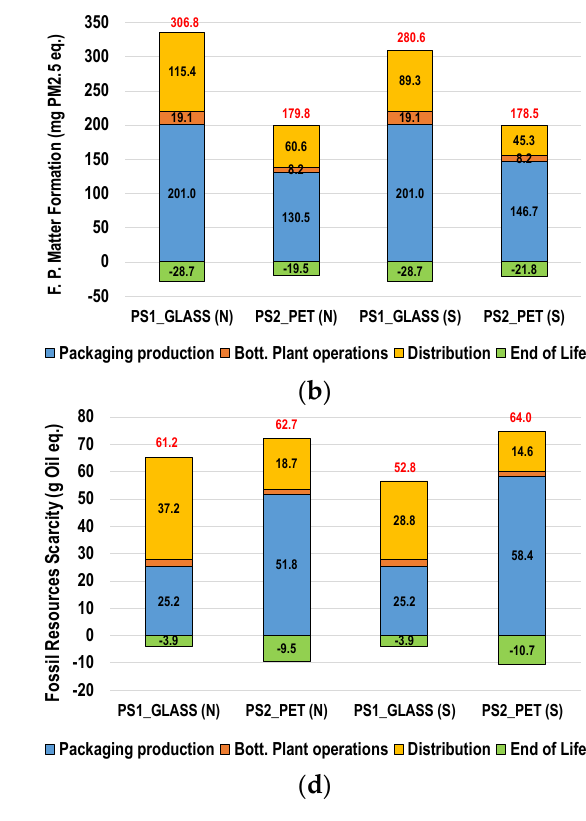
Figure 4. Environmental impacts of the life cycle stages of the packaging systems for natural and sparkling water calculated with the most significant midpoint categories for this study: ( a ) Global warming; ( b ) Fine particulate matter formation ( c ) Terrestrial acidification ( d ) Fossil resources scarcity.